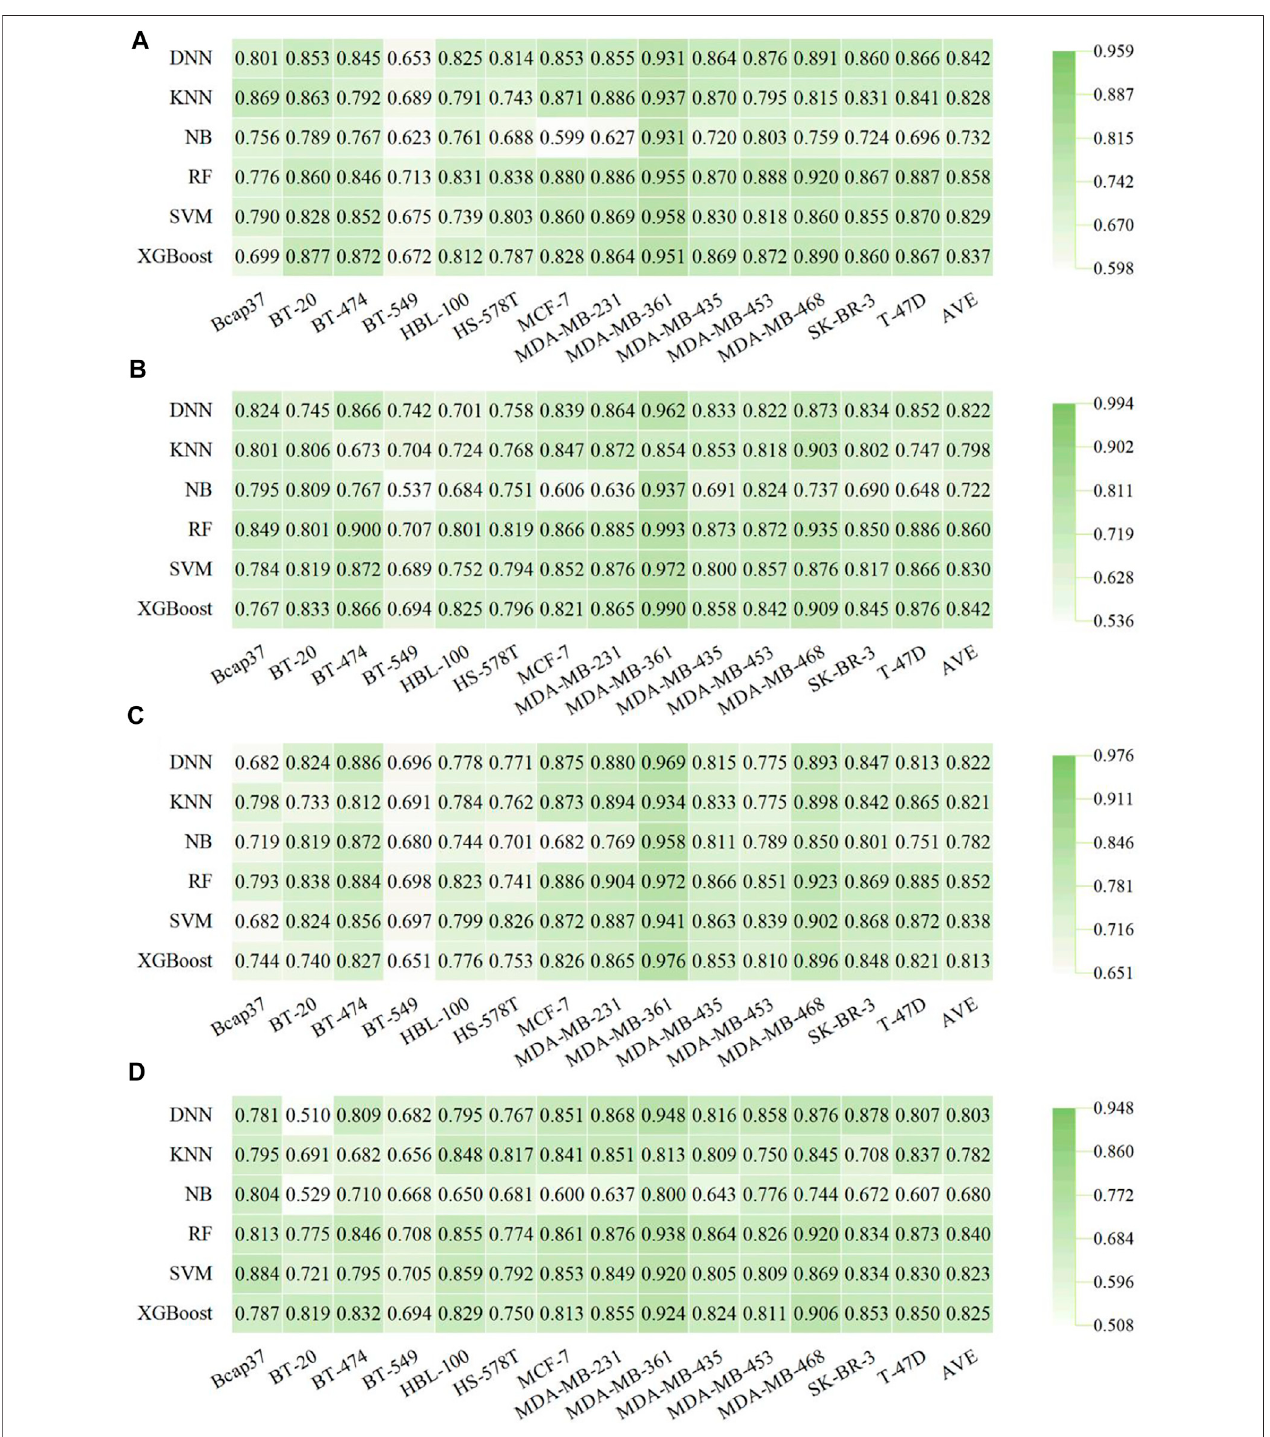
FIGURE 4 | Performance of fi ngerprint-based BC prediction models. (A) AUC results of the AtomPairs-based models. (B) AUC results of the MACCS-based models. (C) AUC results of the Morgan-based models. (D) AUC results of the PharmacoPFP-based models.